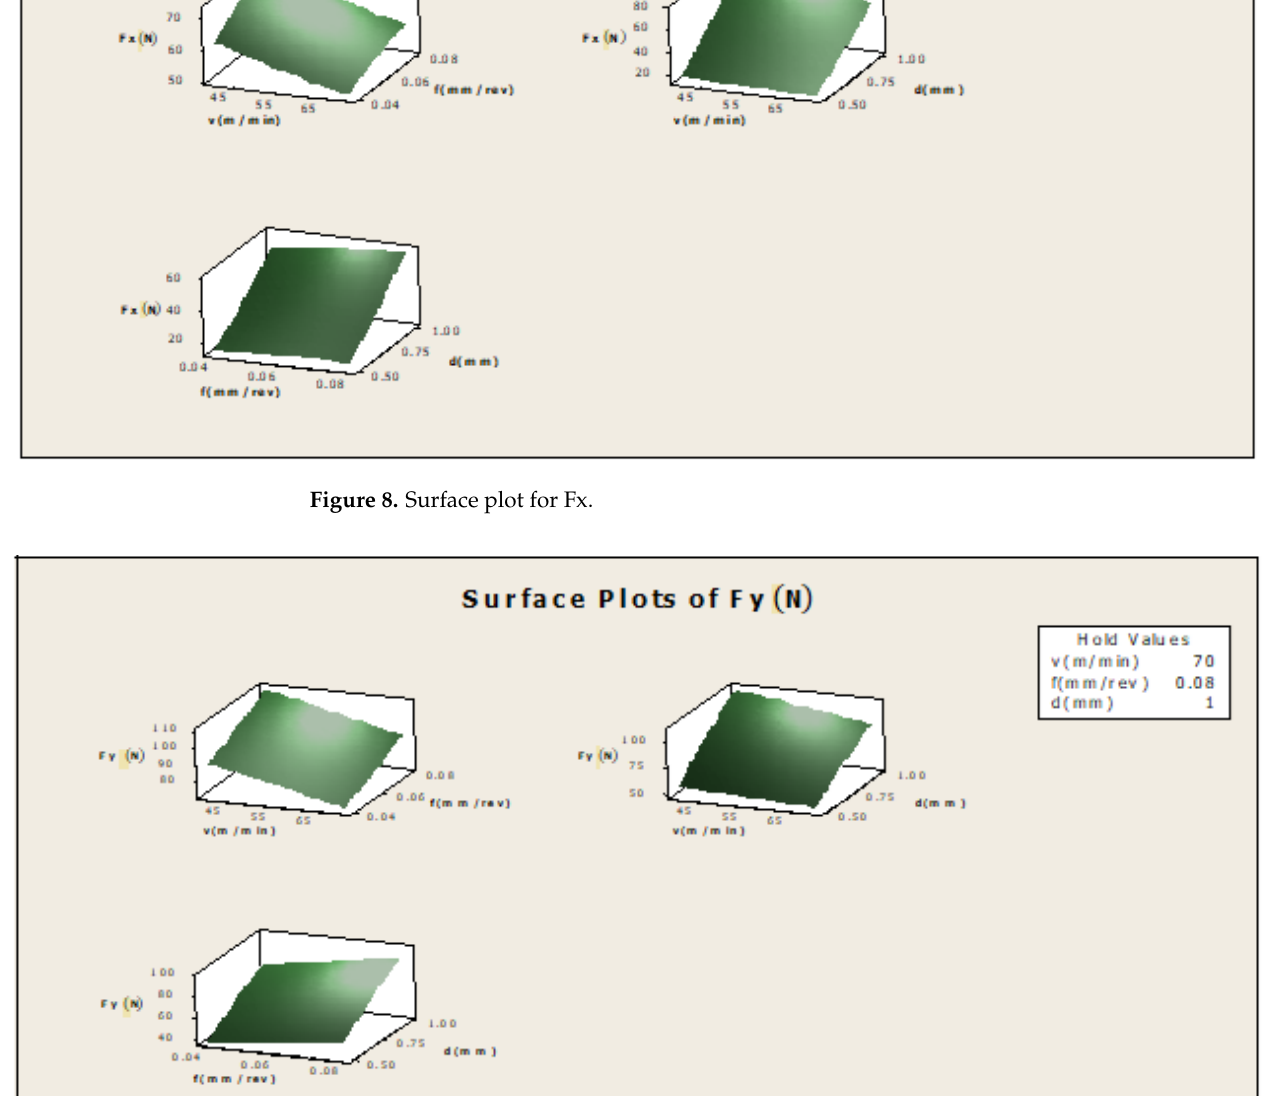
Figure 9. Surface plot for F Y .